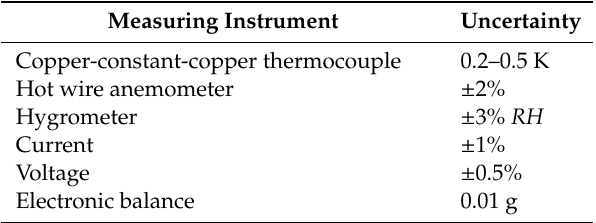
Figure 9. The testing diagram of the testing rig. Table 2. The uncertainties of the measuring